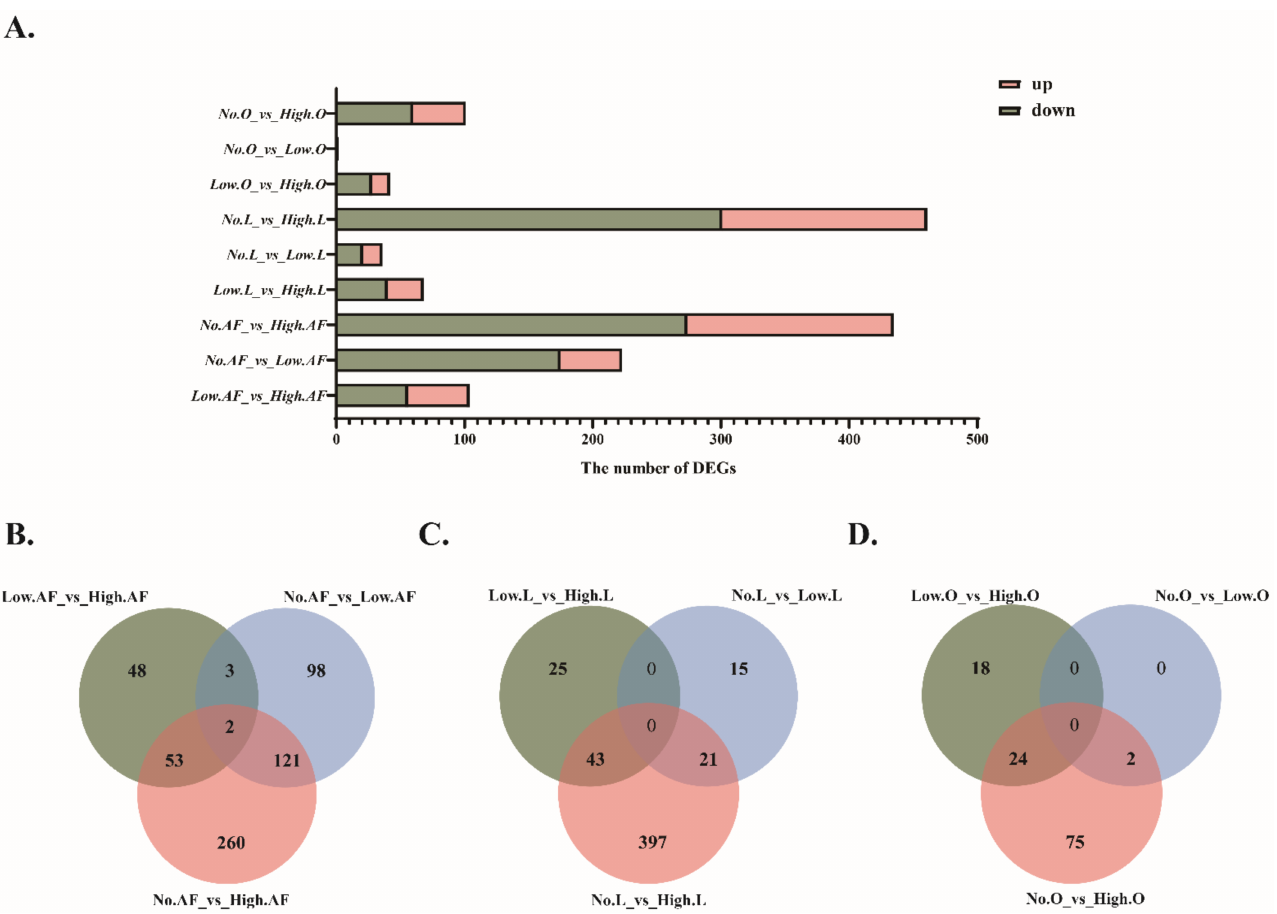
Figure 2. The number of DEGs in different groups. ( A ) Histogram of the number of DEGs in different groups. Venn diagram of the common DEGs between three pairwise comparisons in abdominal fat ( B ), liver ( C ), and ovarian stroma ( D ). “AF” means abdominal fat, “L” means liver, “O” means ovarian